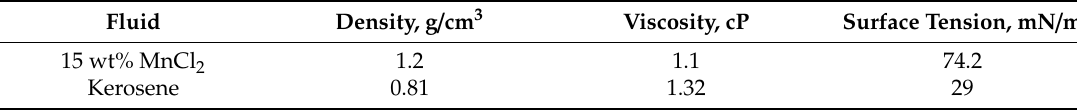
Table 3. The basic properties of the experimental fluid (25 ◦